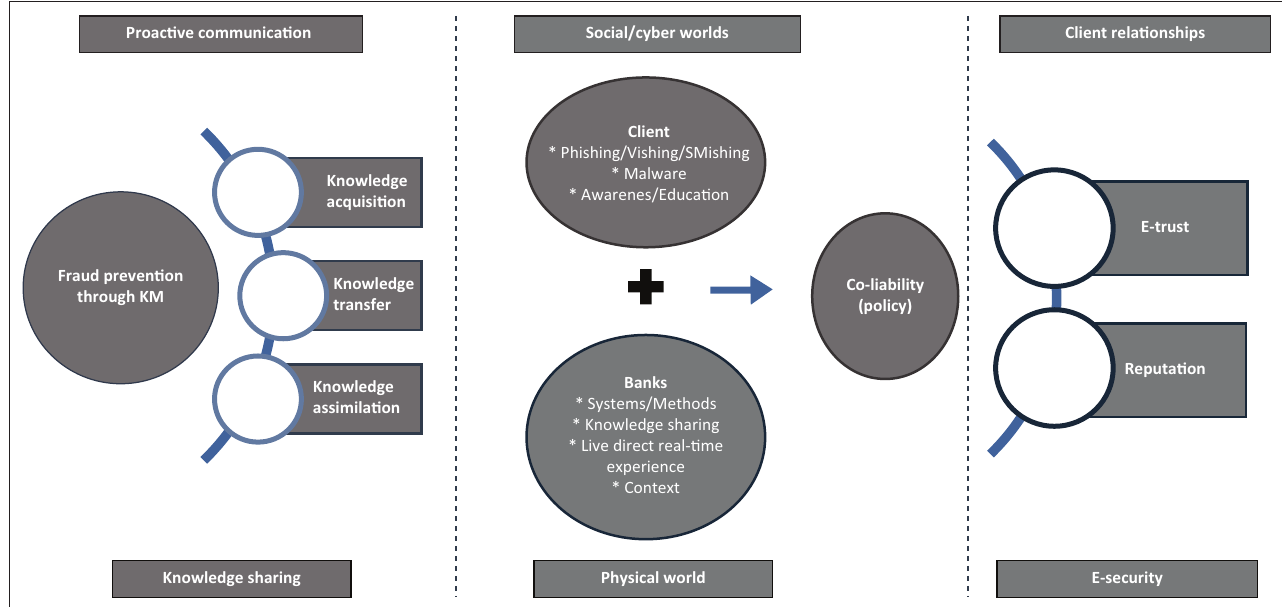
FIGURE 1: Conceptual framework for e-banking fraud prevention through knowledge management.